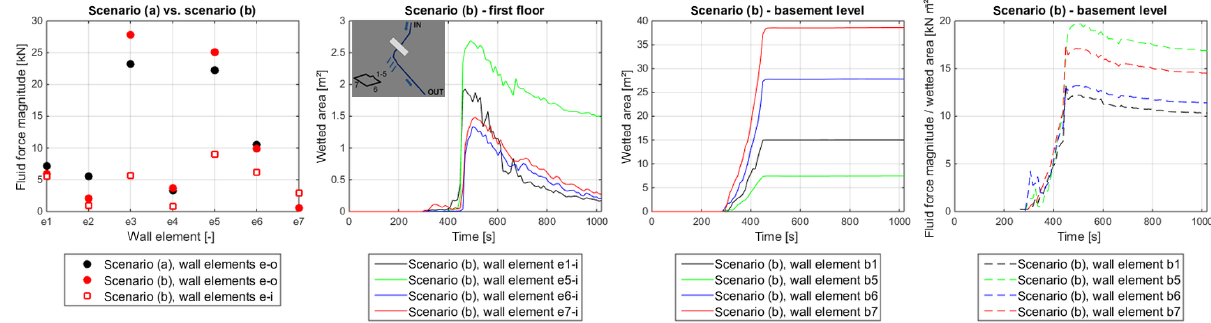
Figure 9. (Left) fluid force magnitudes (kN) on the building envelope for the scenarios (a) and (b); (middle) wetted areas of wall ele- ments (m 2 ) inside the building for scenario (b); (right) specific fluid force magnitudes (kNm − 2 ) at wall elements on the basement level for scenario